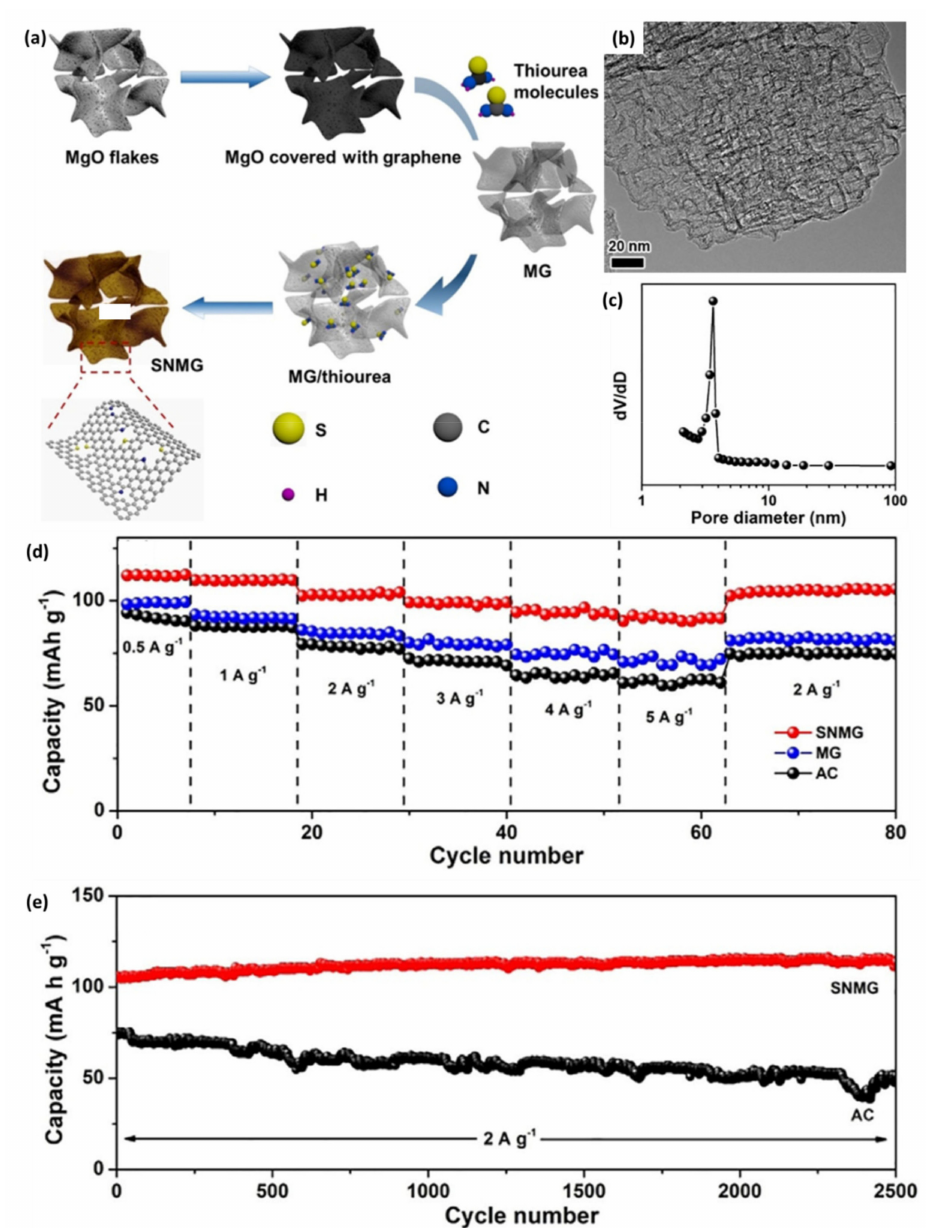
Figure 4. ( a ) Schematic of the preparation process of SNMG; ( b ) TEM image and ( c ) PSD of SNMG; ( d ) Rate capability of SNMG, MG and AC; ( e ) Cycling stability of SNMG and AC. (Reprinted with permission from Ref. [96]. Copyright 2018